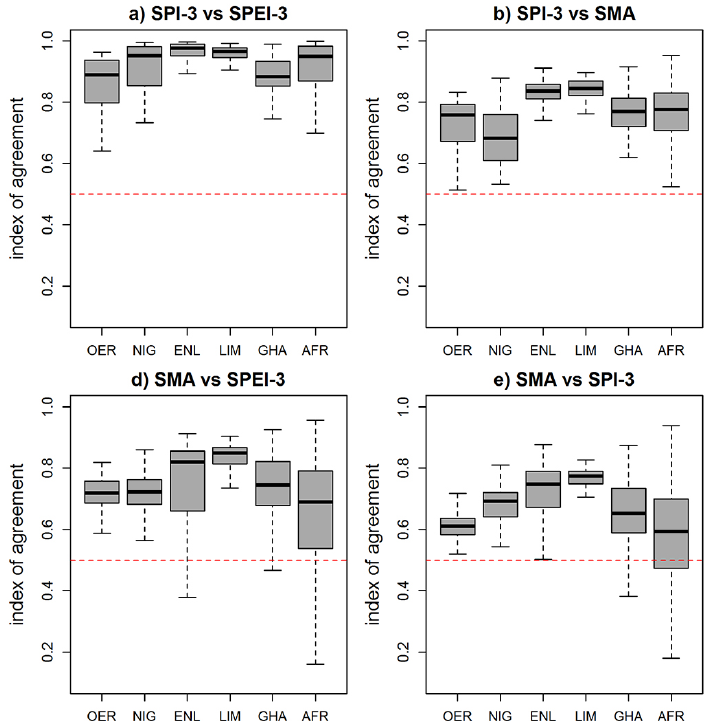
Fig. 5. Index of agreement ( d ) between SPI, SPEI and SMA computed using ERA-I for the five case studies and the whole continent. OER: Oum er-Rbia, NIG: Inner Niger Delta, NIL: Eastern Nile, LIM: Limpopo Basin and GHA: Greater Horn of Africa. Dashed lines extend from 5th to 95th percentile of estimations, boxes extend from 25th to 75th percentile and middle horizontal lines within each box indicate the mean for each